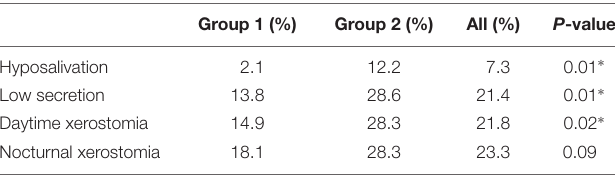
TABLE 4 | Prevalence of hyposalivation (UWS ≤ 0.10 ml/min), low secretion (UWS < 0.20 ml/min), daytime and nocturnal xerostomia in group 1 and 2 and in the whole study population.